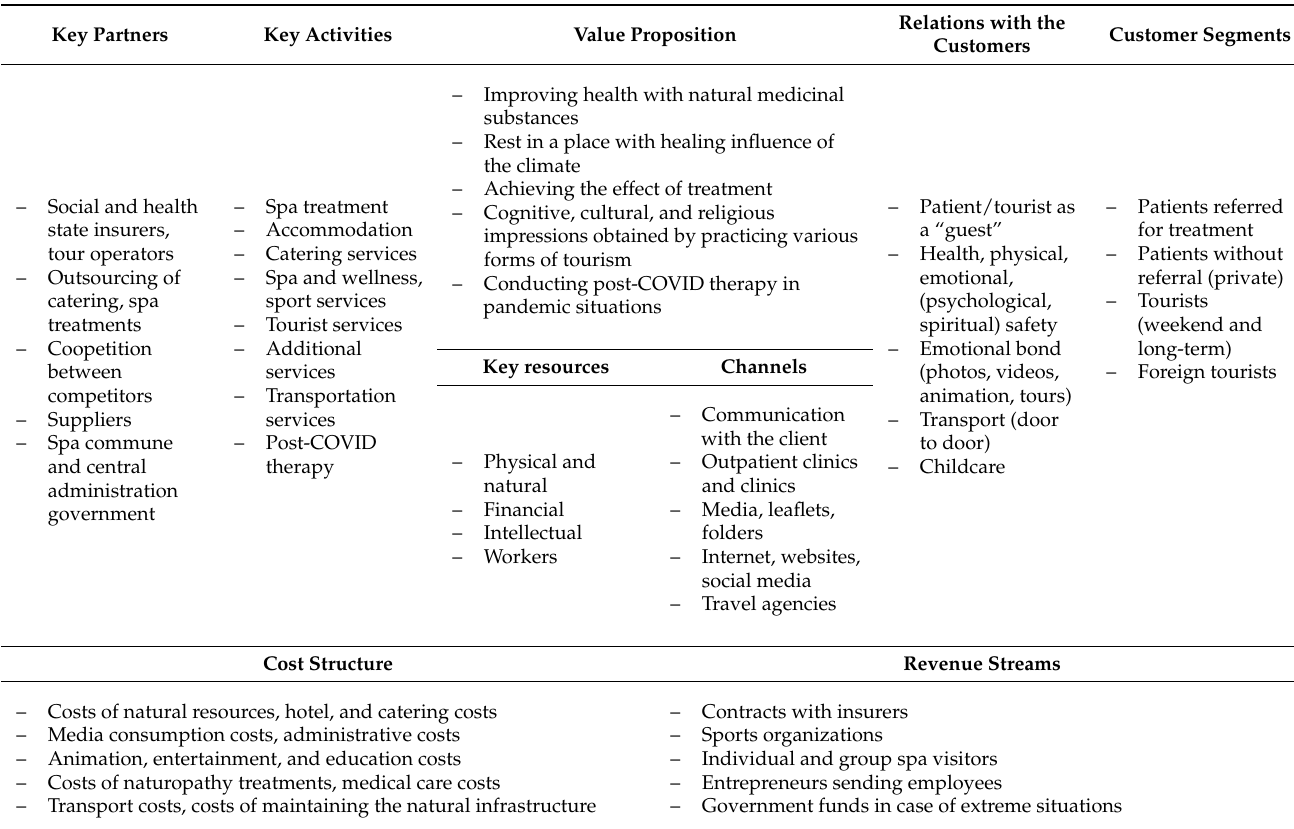
Table 2. The business model of spa tourism